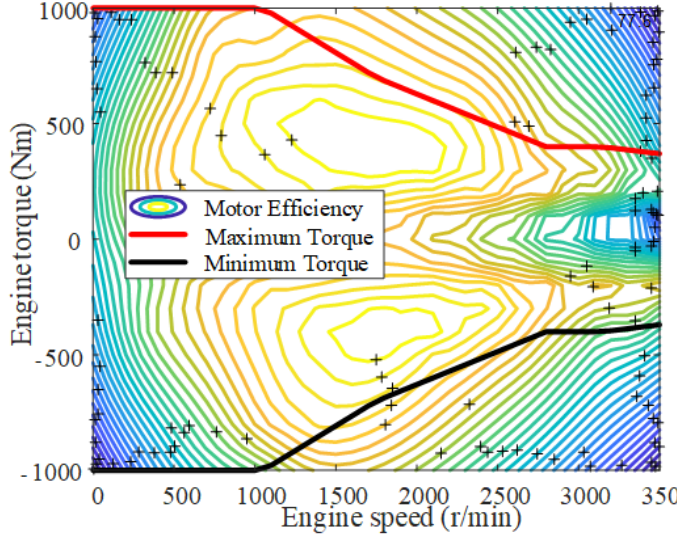
Figure 3. Motor efficiency